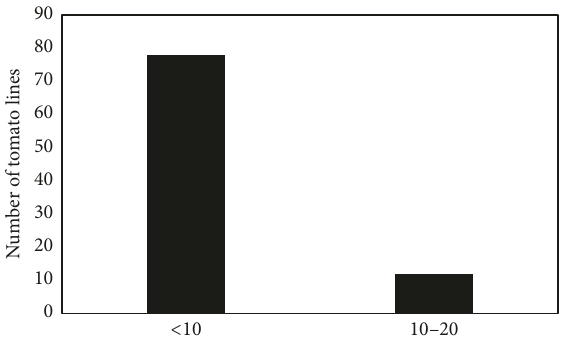
Figure 5: Distribution of tomato genotypes in relation to number of fruits per inflorescence.